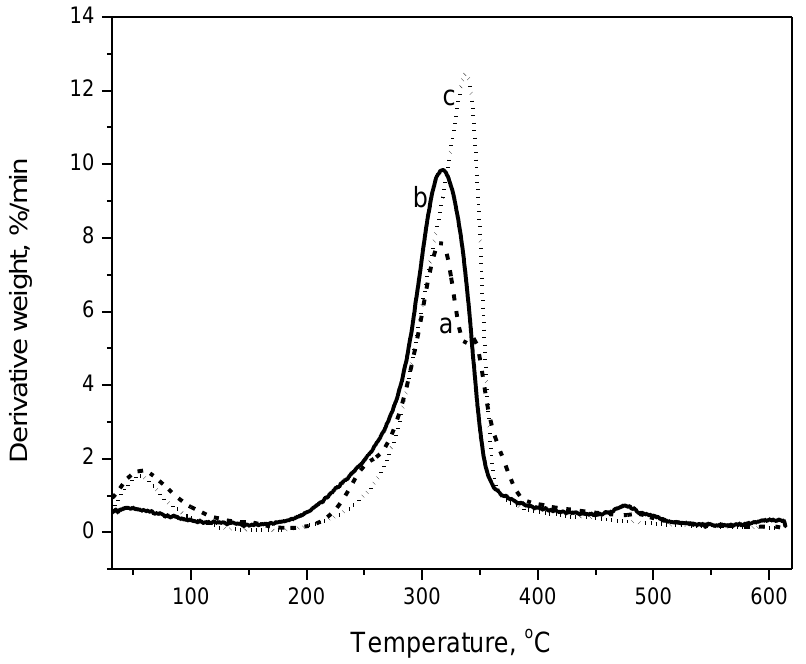
Figure 5. Derivative thermogravimetric (DTG) curve of ( a ) raw CP, ( b ) CNF procedure I, and ( c ) CNF procedure II. Table 4. TG thermal properties of samples.